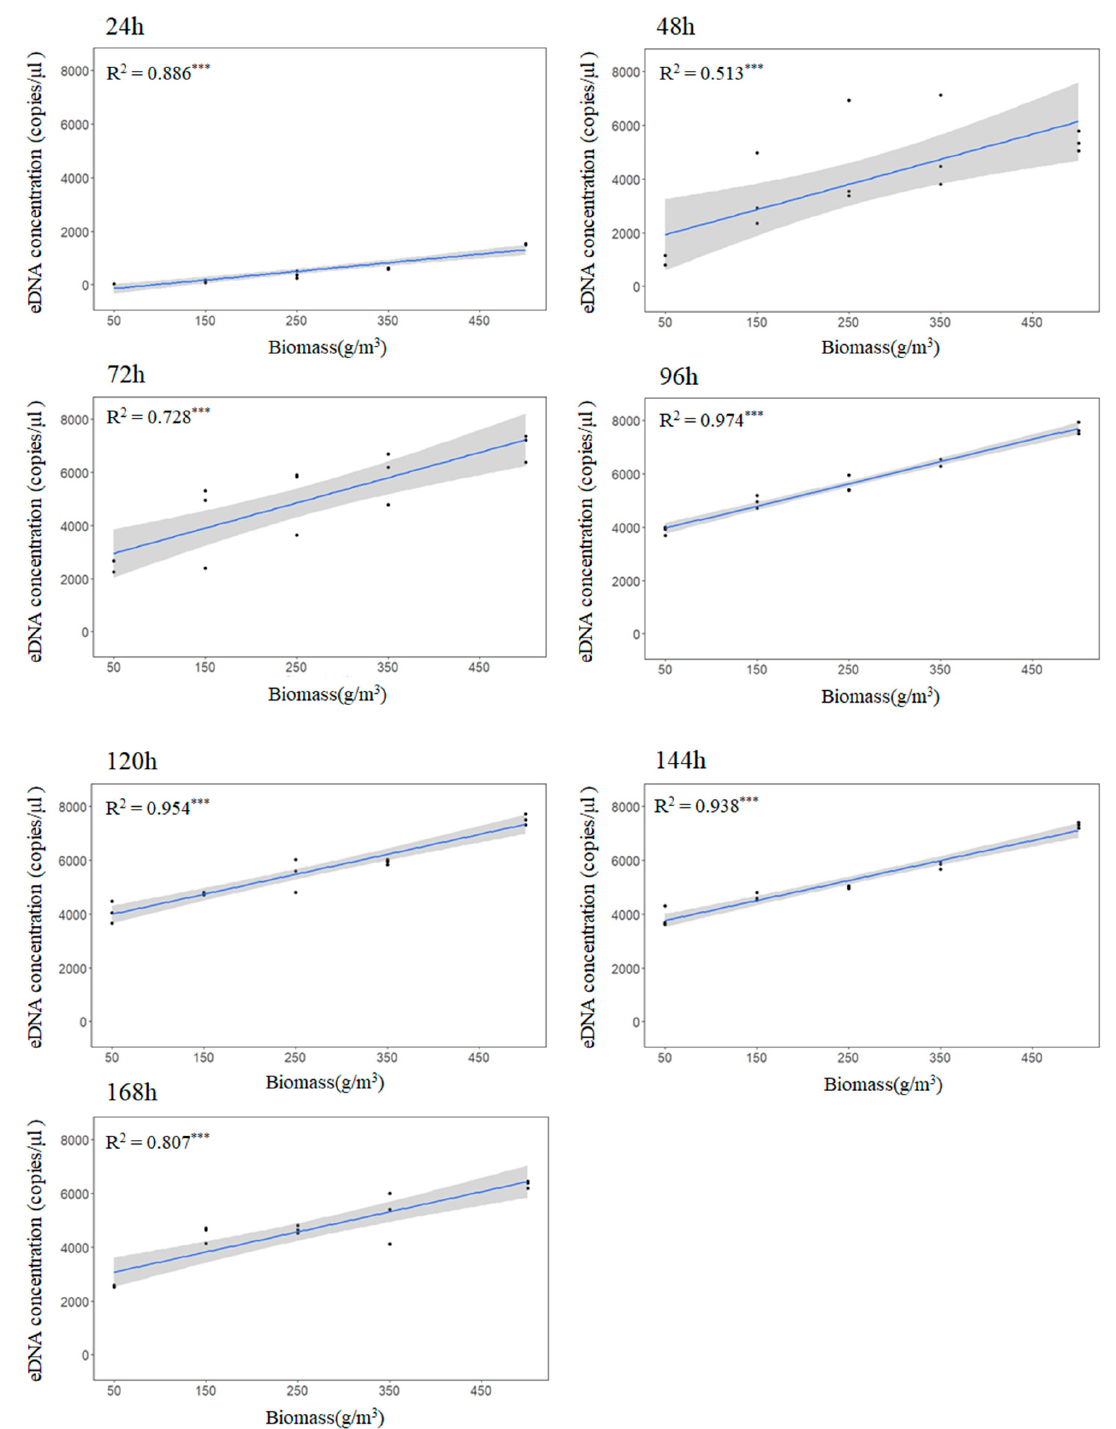
Figure 2. Relationship between the biomass and eDNA concentration of A. latus . Points indicate the data (biomass: 50 g/m 3 , 150 g/m 3 , 250 g/m 3 , 350 g/m 3 , and 500 g/m 3 ). The eDNA concentrations (copies/ µ L) as a function of yellowfin seabream biomass (g/m 3 ) at seven sampling time points (24, 48, 72, 96, 120, 144, and 168 h after the yellowfin seabream were introduced to the tanks) are shown. Each data point represents the mean value from three replicates. The grey shaded areas around the regression lines show the 95% confidence interval. R 2 values were calculated for each time point separately (*** = p < 0.001).